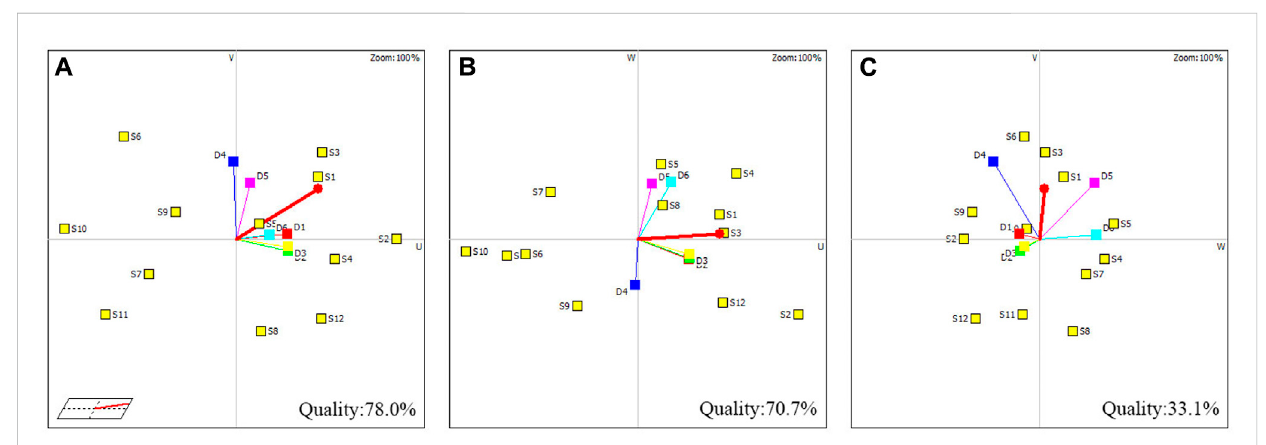
FIGURE 9 PROMETHEE Rainbow fi gure.